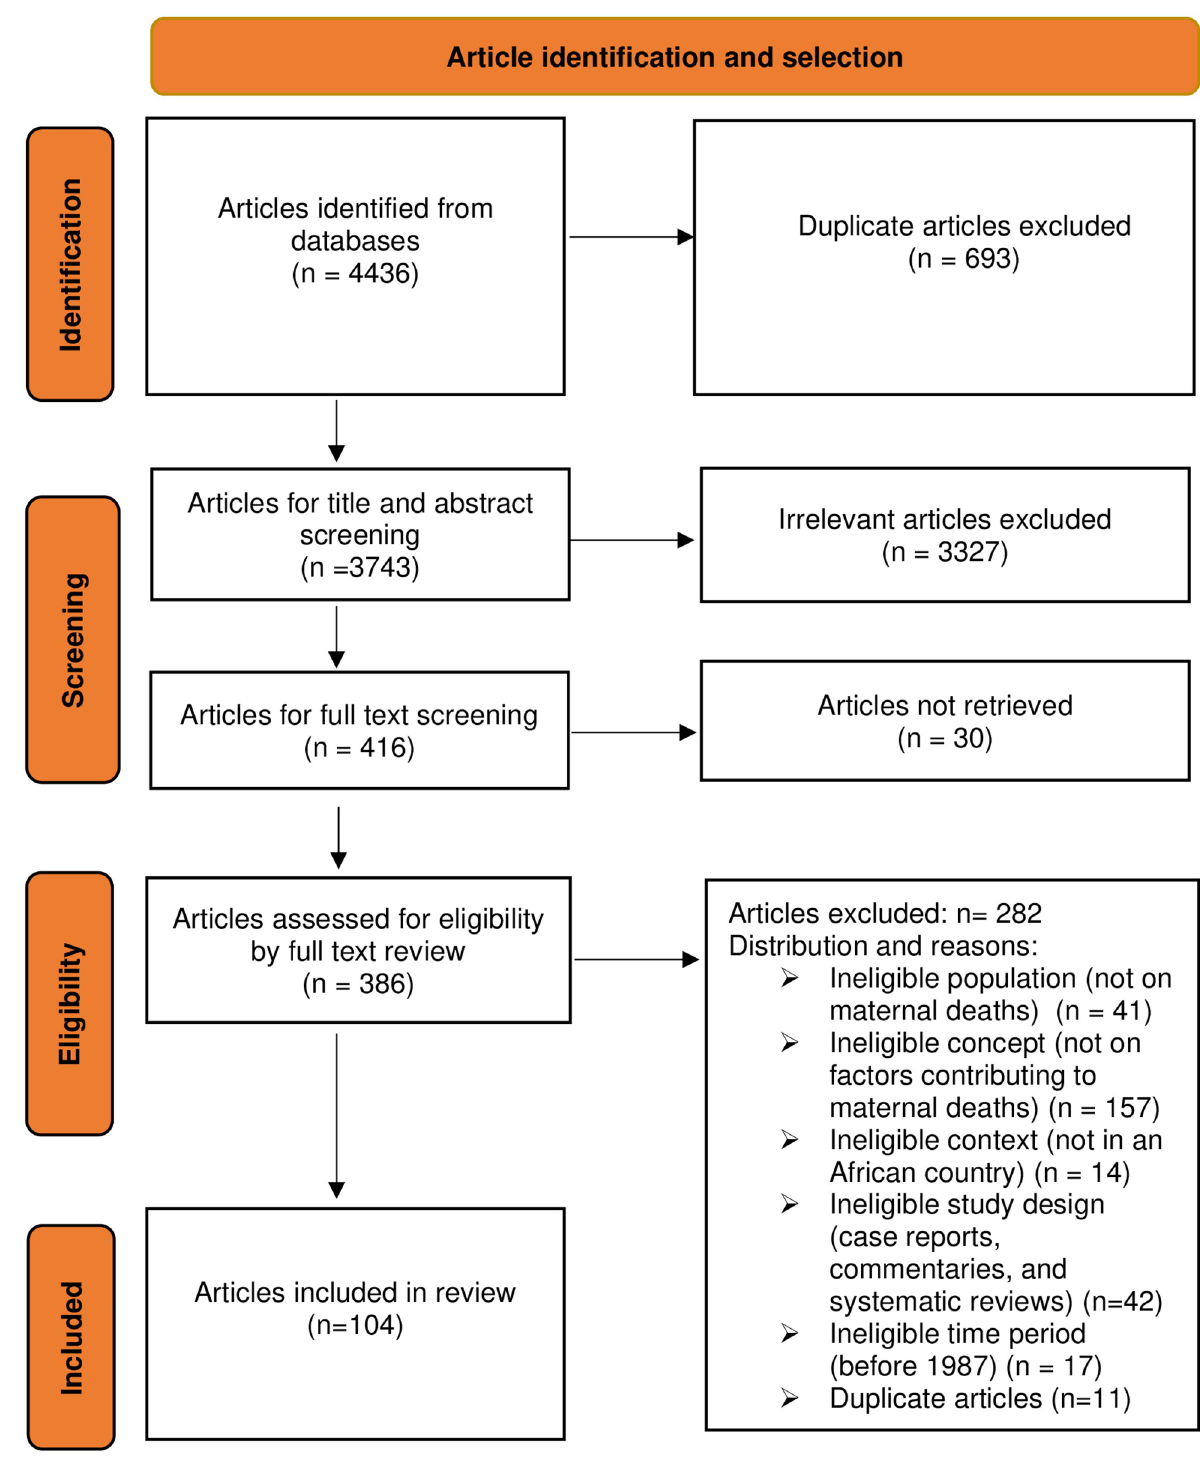
Fig 2. Prisma flow chart of the scoping review process. The flow chart illustrates the stages of article processing from identification from the various databases, screening using the inclusion and exclusion criteria, and inclusion in the review. In the final screening, primary articles reporting on maternal deaths (population), factors contributing to maternal deaths (concept) and within an African country (setting) were included.